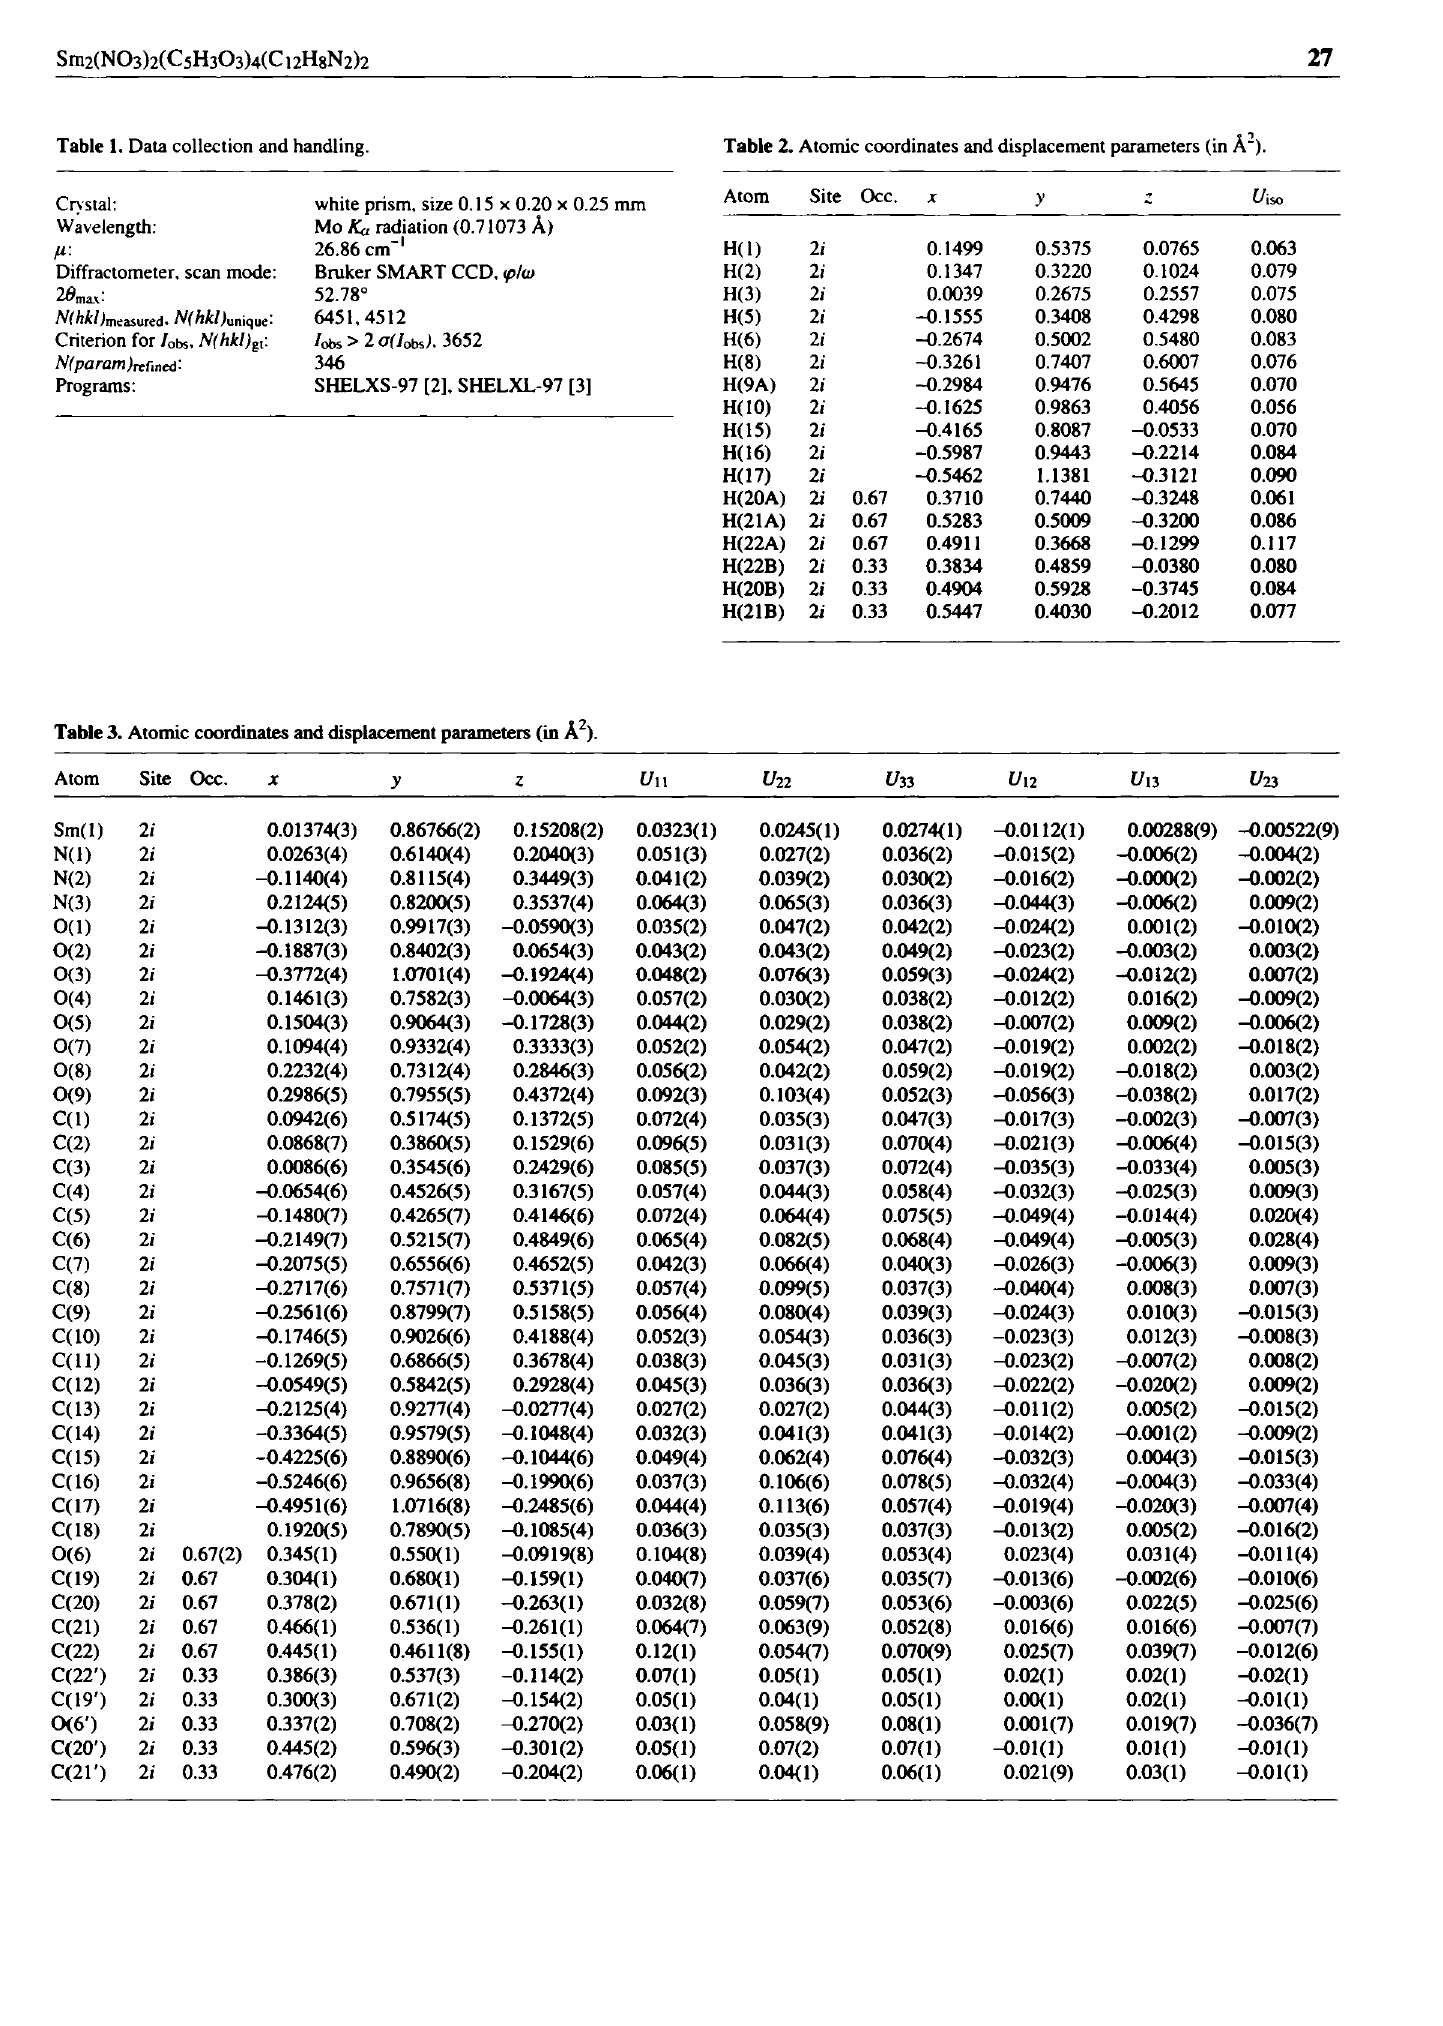
Table 1. Data collection and handling. Table 2. Atomic coordinates and displacement parameters (in Â 2 ).